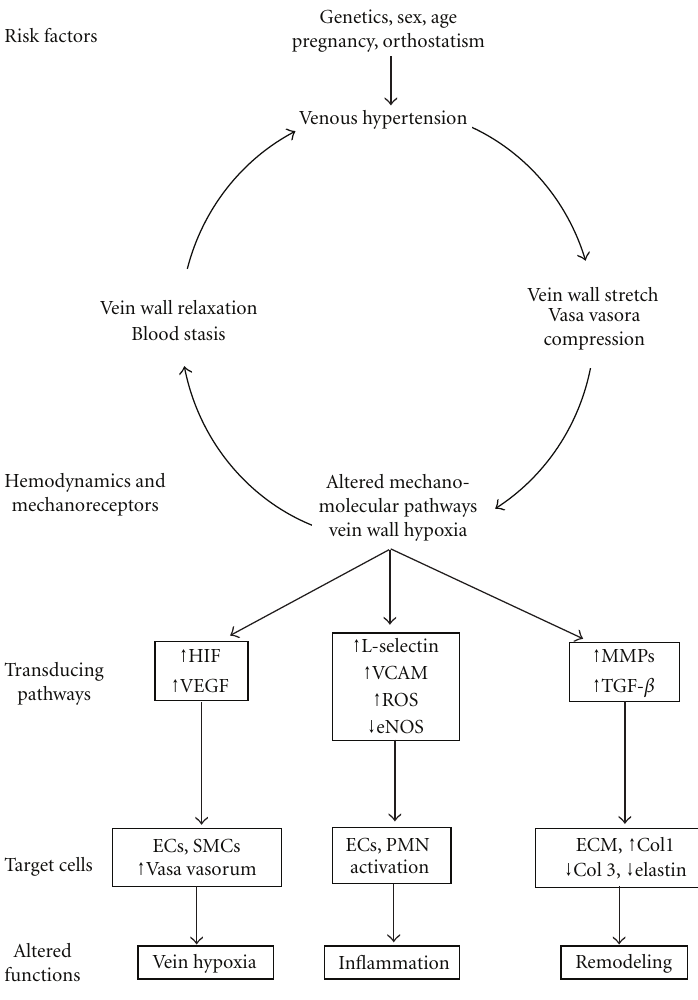
Figure 3: Signaling pathways of varicose vein